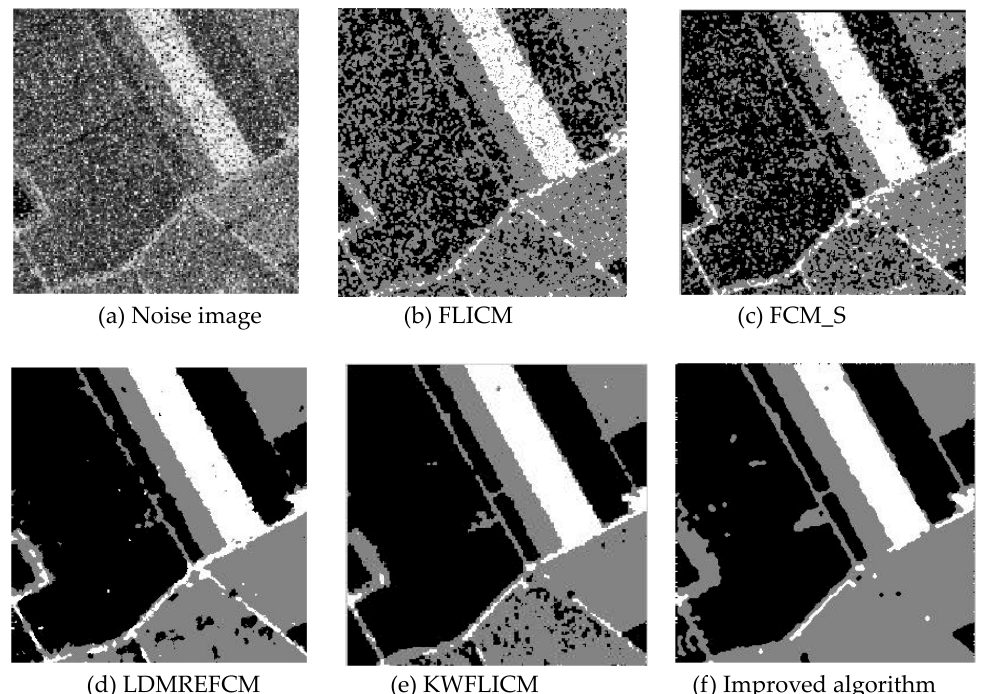
Figure 6. Disturbance of salt-and-pepper noise on remote sensing image 1 ( a ) and the segmentation results ( b – f ).